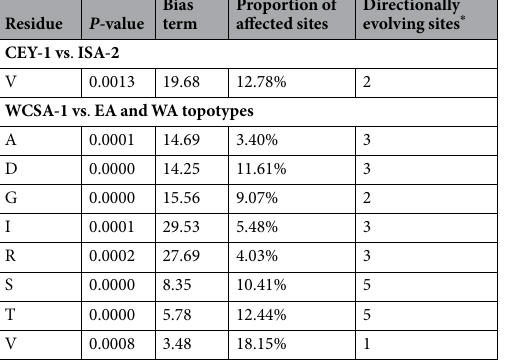
Table 2. Selected residue report of the DEPS analyses. * The details of the sites are given in Table 3.